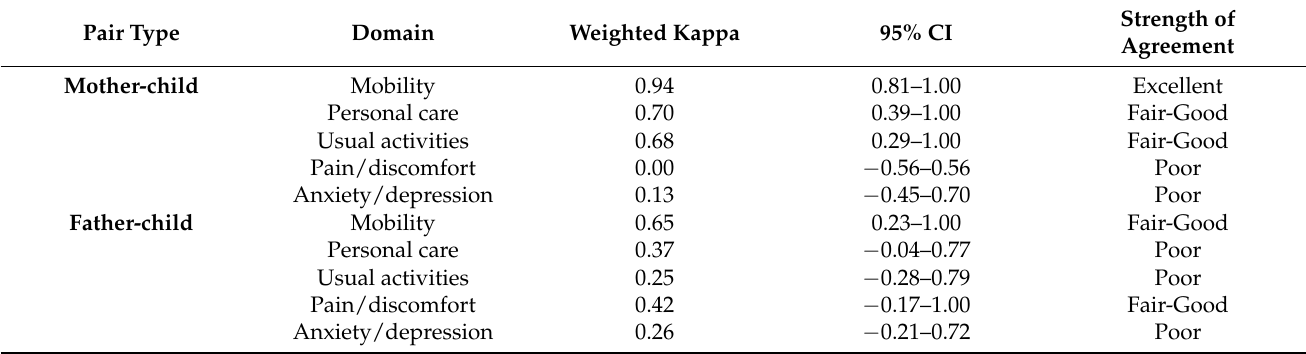
Table 8. Parent–child concordance of patient QoL on EQ-5D-Y